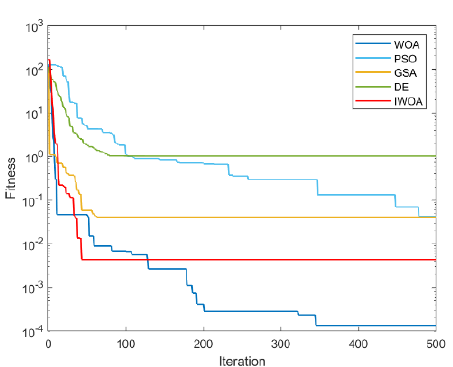
Figure 10. F5. Figure 10. F5.